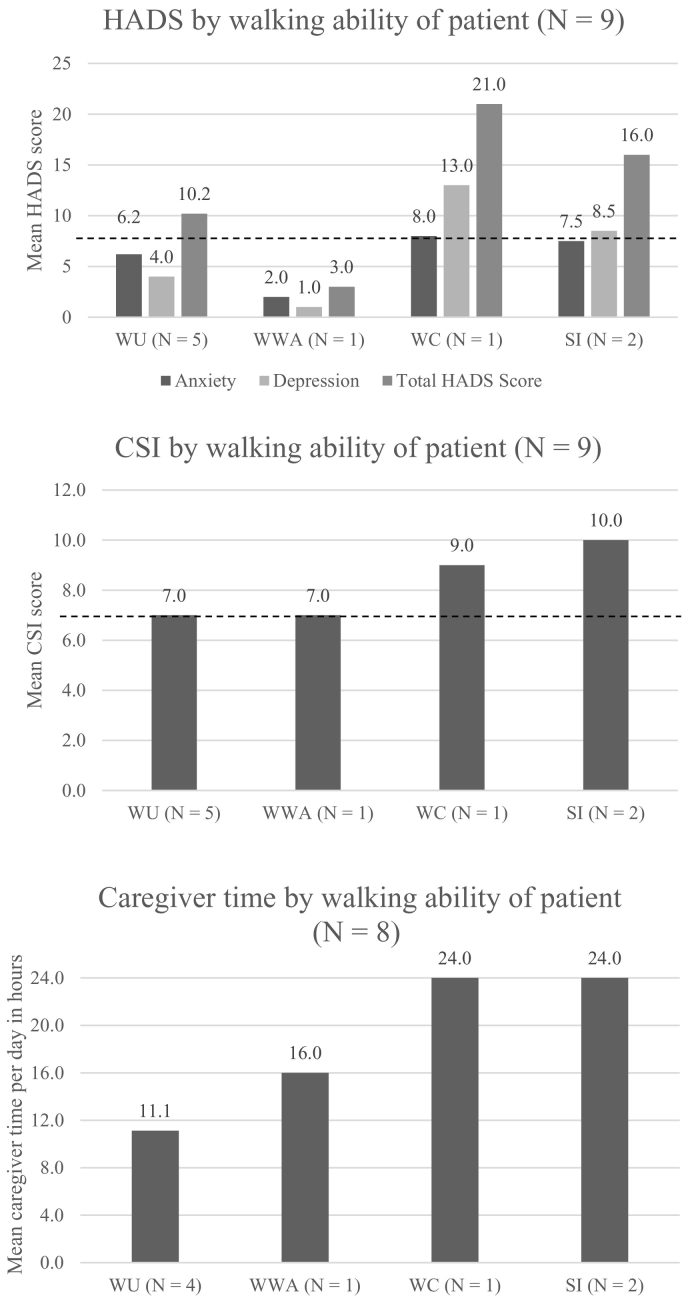
QoL of carers measured by walking ability of the patient using the HADS questionnaire (top), CSI questionnaire (middle) and caregiver time per day (bottom) For HADS, carer scores for anxiety and depression subscales go up to 21 each. 0–7: no case; 8–10: borderline abnormal case; 11–21: abnormal case. For CSI, carer scores go up to 12, with a score of 7 or higher indicating the carer is under a high level of stress related to care provision. Blue horizontal dotted lines indicate the level at which there is a borderline abnormal case for HADS for each subscale or a high level of stress related to care provision for CSI.Abbreviations: CSI, Caregiver Strain Index; HADS, Hospital Anxiety and Depression Scale; HRQoL, health-related quality of life; SI, severe immobility; WC, wheelchair-dependent; WU, walking unassisted; WWA, walking with assistance. (For interpretation of the references to colour in this figure legend, the reader is referred to the web version of this article.)